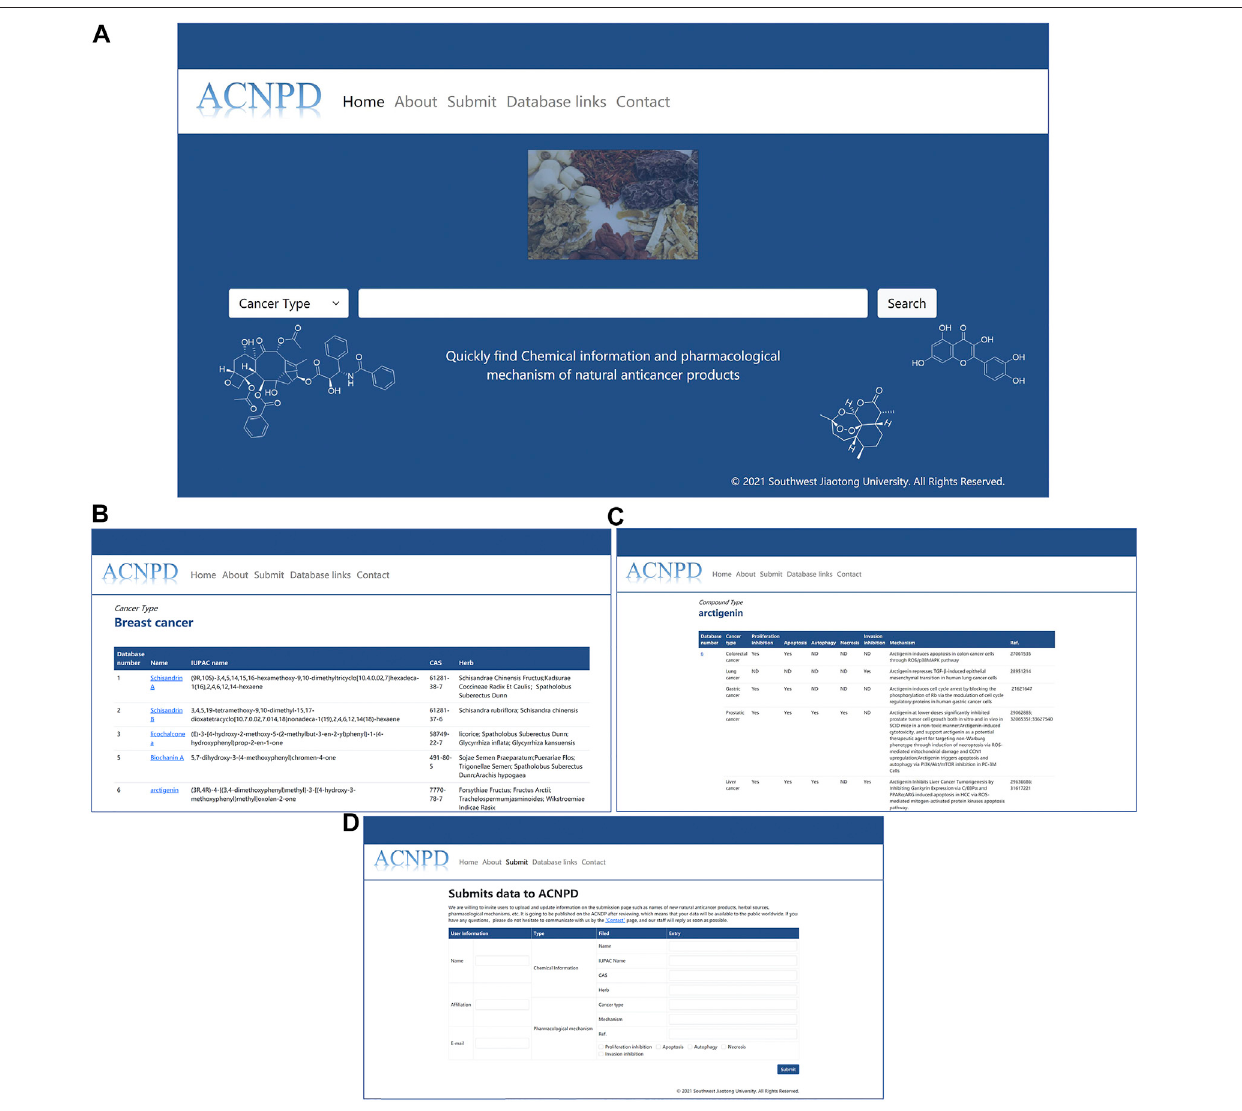
FIGURE 3 | Interface of ACNPD website. Users can search the database in two ways and query the detailed information through a link. For example, users can query not only by entering a cancer type name (such as Breast cancer) as a keyword, but also by entering the name of a compound from a natural product for fi eld retrieval (e.g., arctigenin). (A) Query Home Page; (B) Breast cancer Search Result; (C) Search Result of Compound Arctigenin; (D) Submit